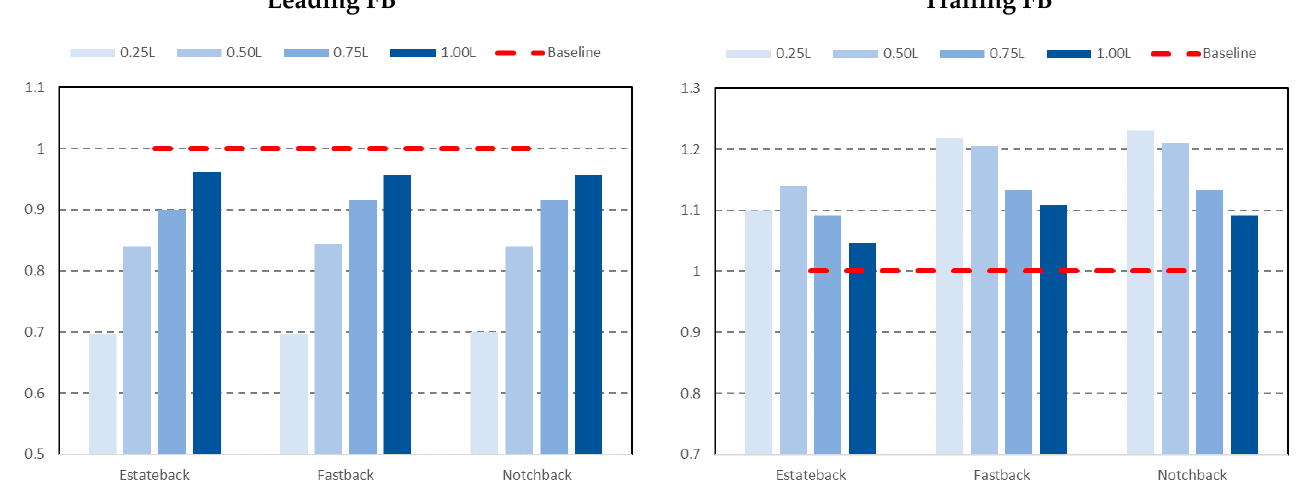
Figure 6. Drag ratios results of a leading FB ( left ) and a trailing FB (right ) in different inter-vehicle spacing and configuration order normalised against the baseline results of an FB.